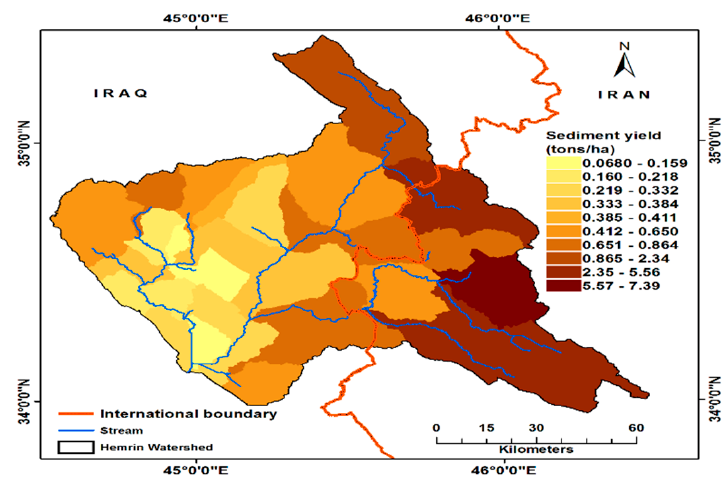
Figure 26. Result of senario-2 (M-2) of sediment mitigation.